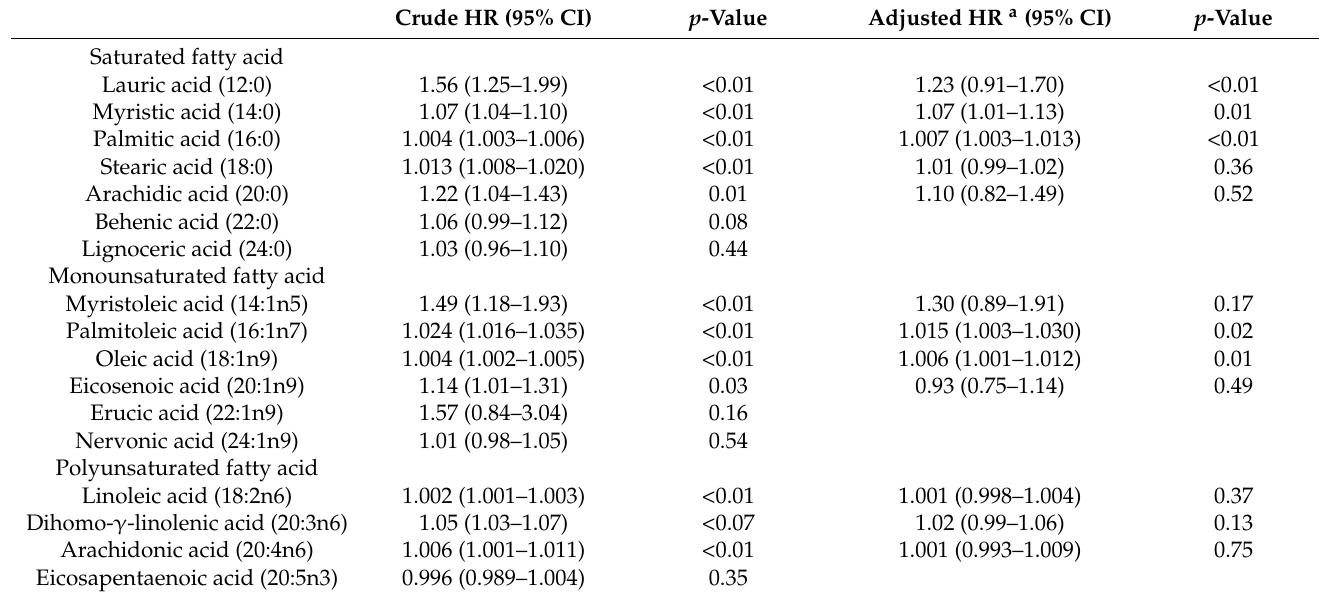
Figure 2. The relationships between fatty acid levels, the metabolic pathway, and NASH histological findings. ↑ indicates elevation in fatty acid levels in advanced fibrosis (Stage 3–4). ↓ indicates reduction in fatty acid levels in advanced fibrosis (Stage 3–4). ↑ indicates elevation in fatty acid levels in high NAS (NAS 5–8). Table 11. Risk of the fatty acids for high